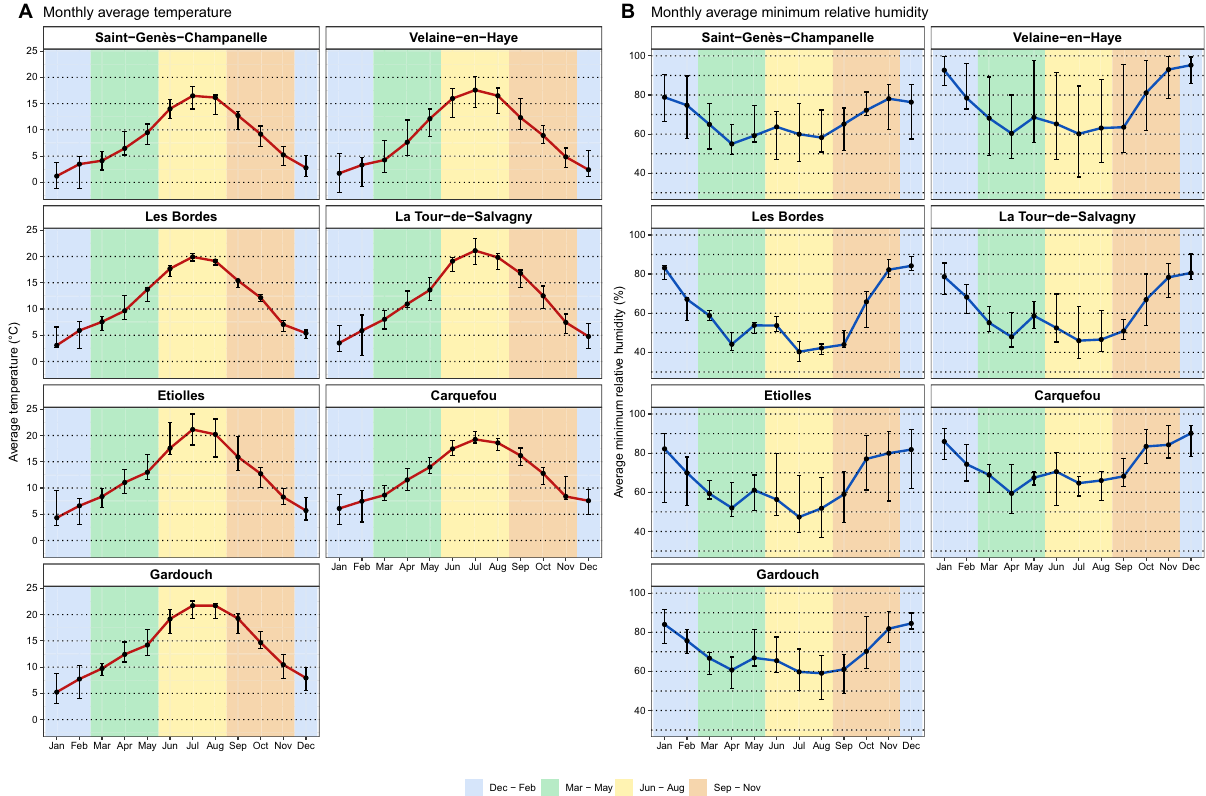
Figure 2. Monthly average meteorological conditions of 7 tick observatories: ( A ) average temperature T M ; ( B ) minimum relative humidity U N . The average values were calculated using the imputed data from January 2013 to June 2021, with the exception of Les Bordes, which was calculated from January 2017 to June 2021. The points represented the median of the monthly average values over the observed period, while the error bars represent the maximum and minimum monthly average values. Background colours indicated meteorological seasons of the temperate areas of northern hemisphere: Spring, 1st March to 31st May (green); Summer, 1st June to 31st August (yellow); Autumn, 1st September to 30th November (brown); Winter, 1st December to 28th or 29th February